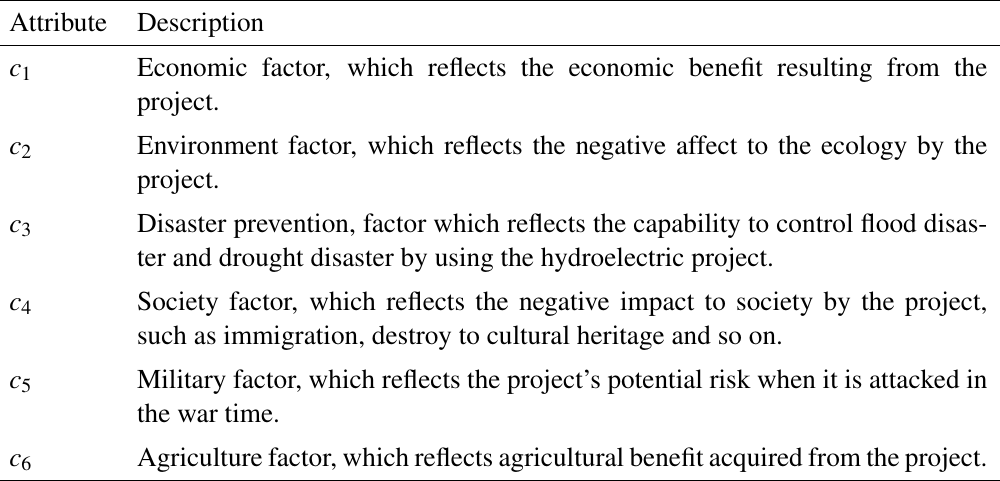
Table 1: Evaluating attributes of MAGDM in a case